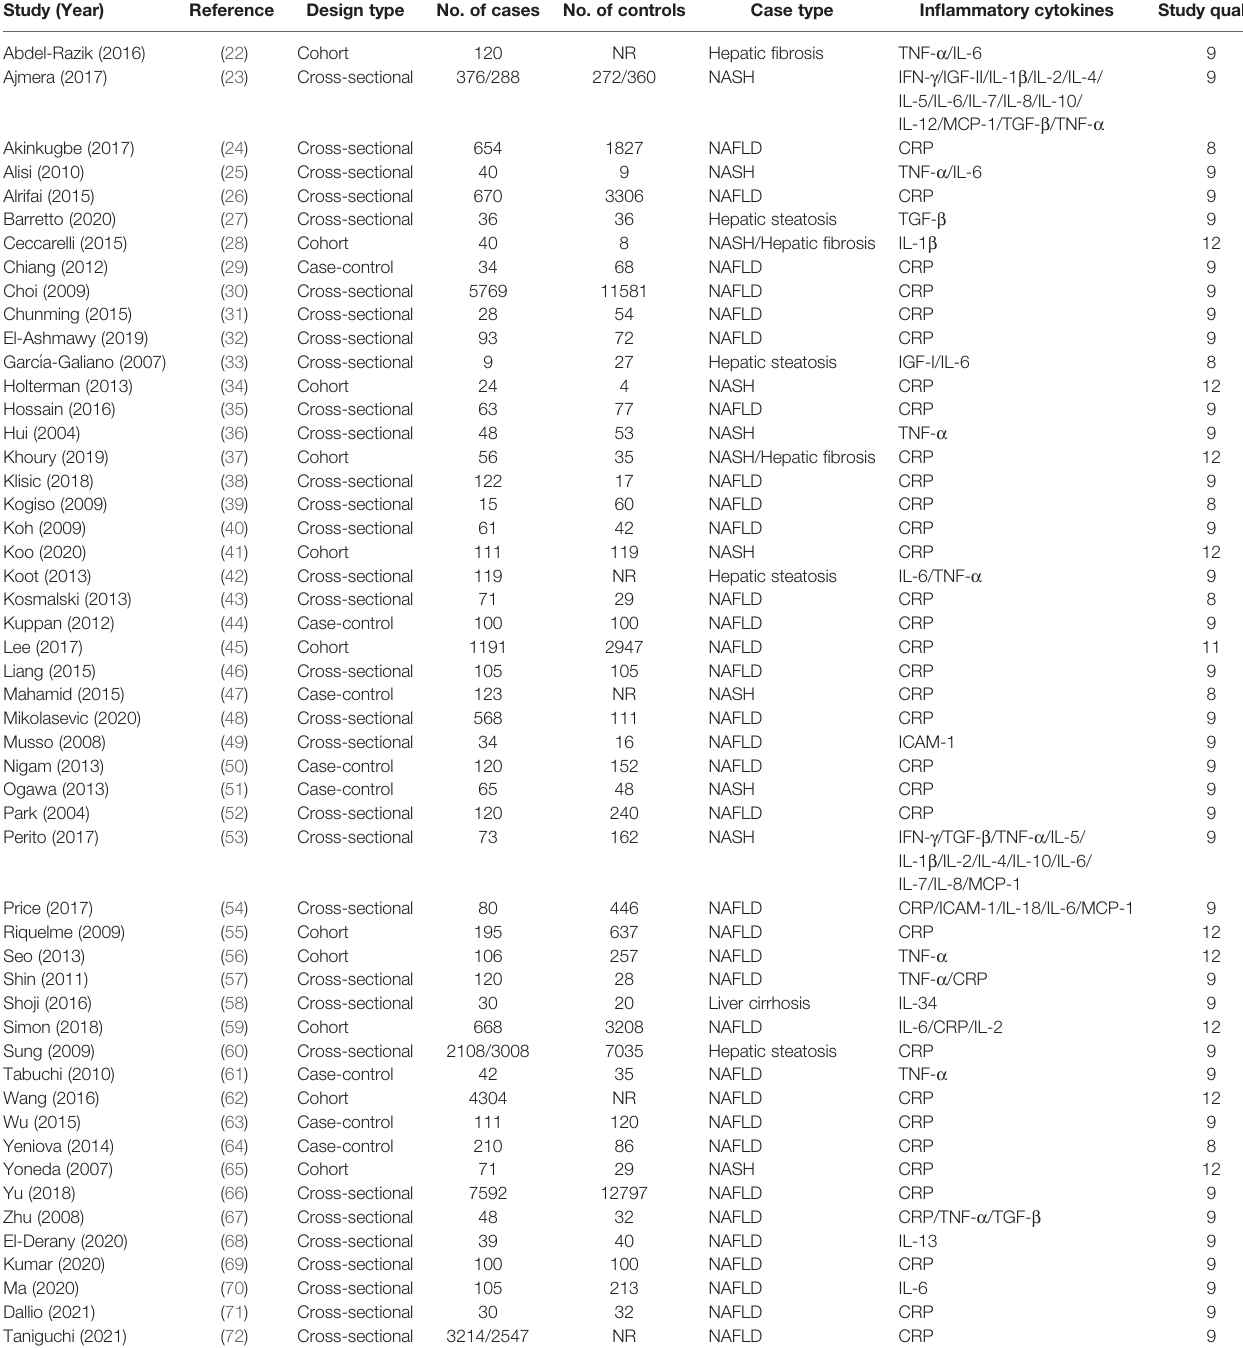
TABLE 1 | Characteristics of included